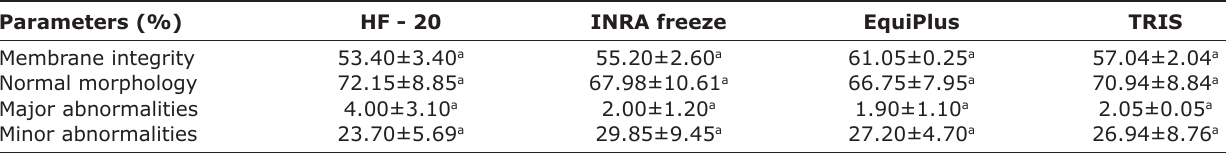
Table-3: Effect of different extenders on chilled stallion semen after 90 min on the plasma membrane integrity and morphology. Parameters (%)